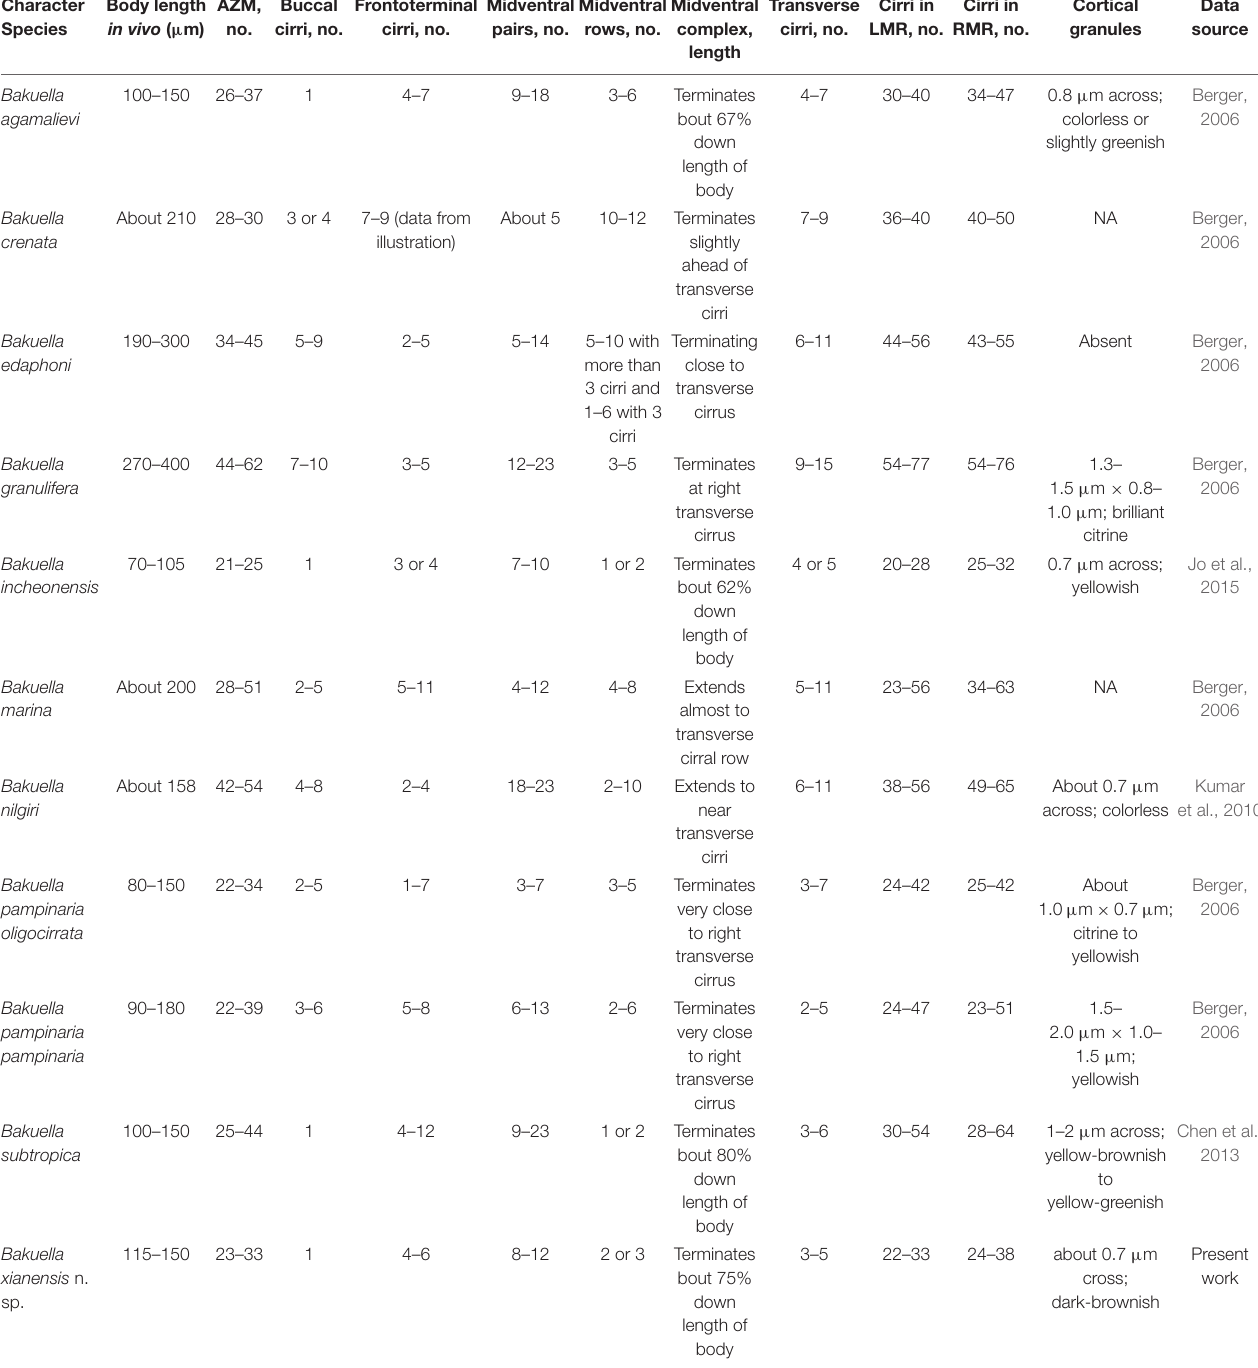
TABLE 3 | Morphological comparison of Bakuella xianensis n. sp. with closely related